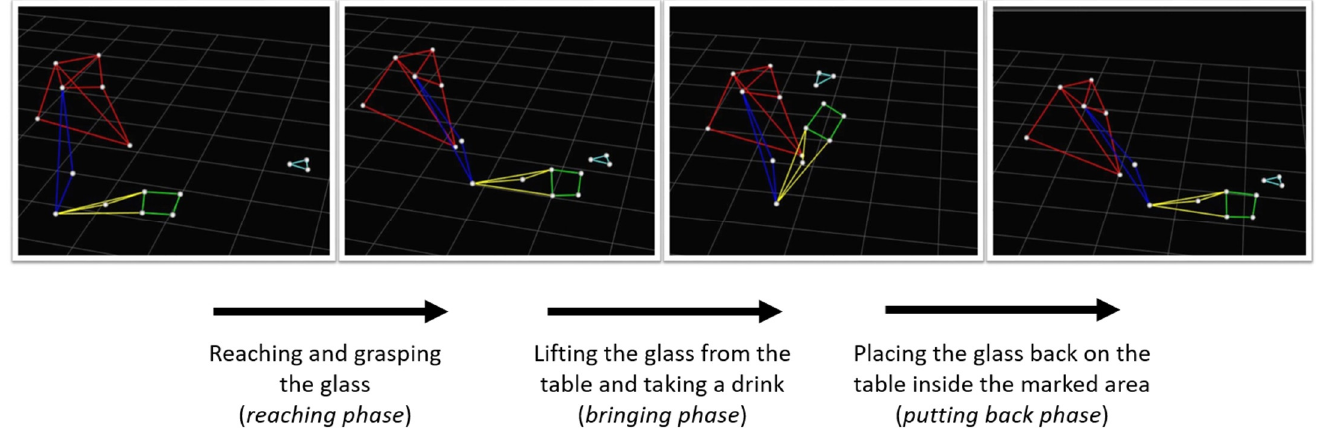
Figure 1. The investigated motor task with the three analyzed phases (reaching, bringing, and putting back).